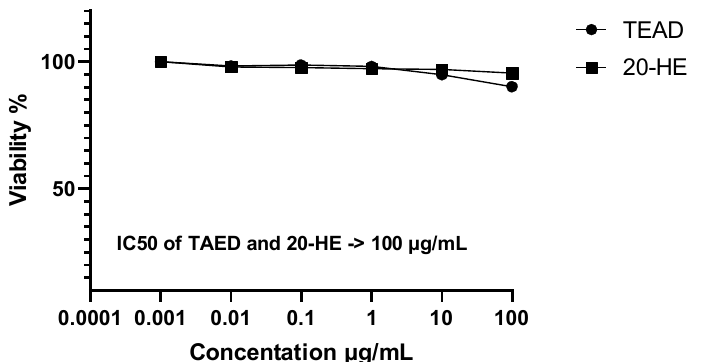
Figure 7. Cell viability and IC 50 values of TEAD and 20-HE on skeletal muscle cells treated for 24 h.